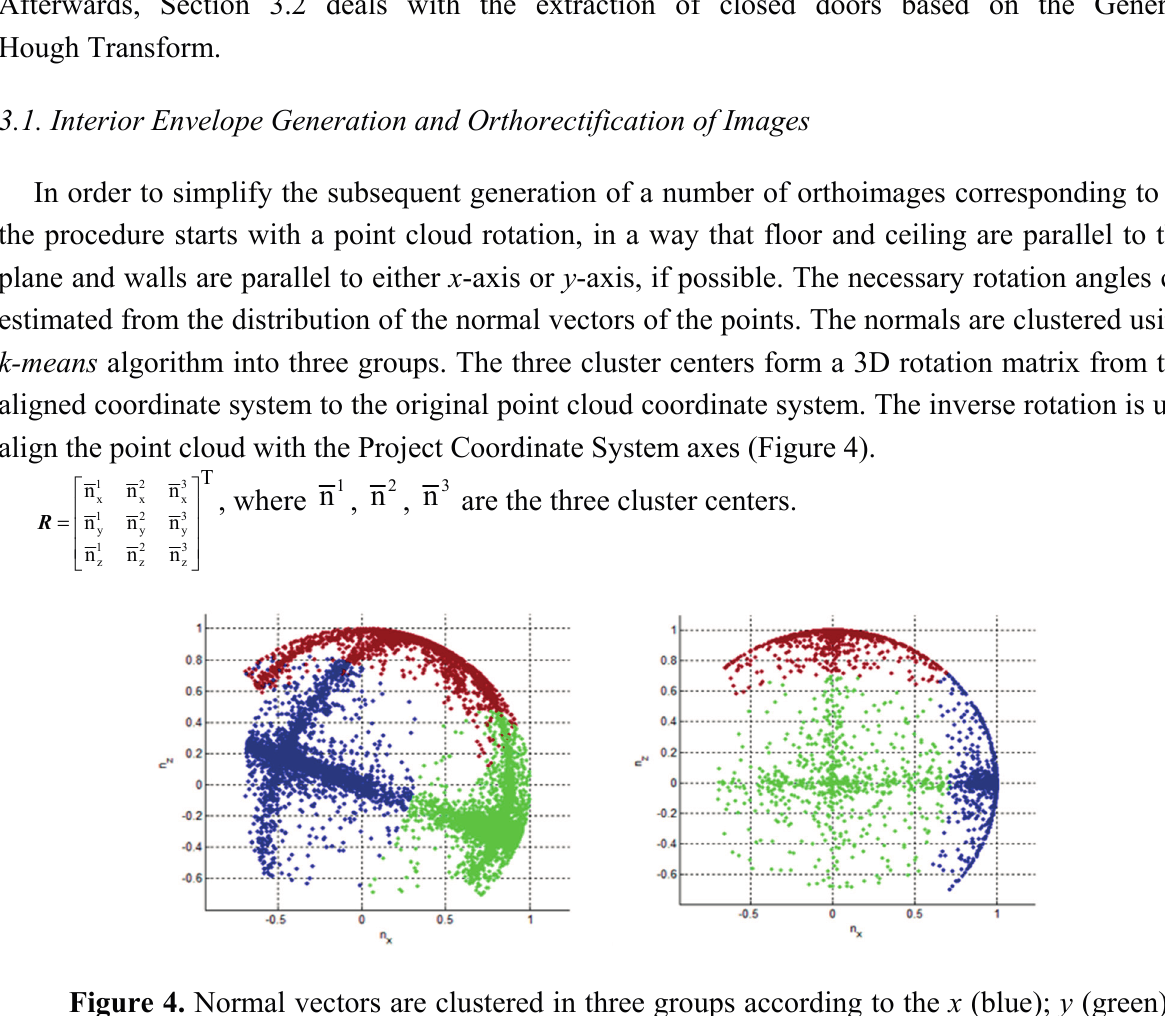
Figure 4. Normal vectors are clustered in three groups according to the x (blue); y (green) and z axes (red); before ( left ) and after ( right ) the rotation